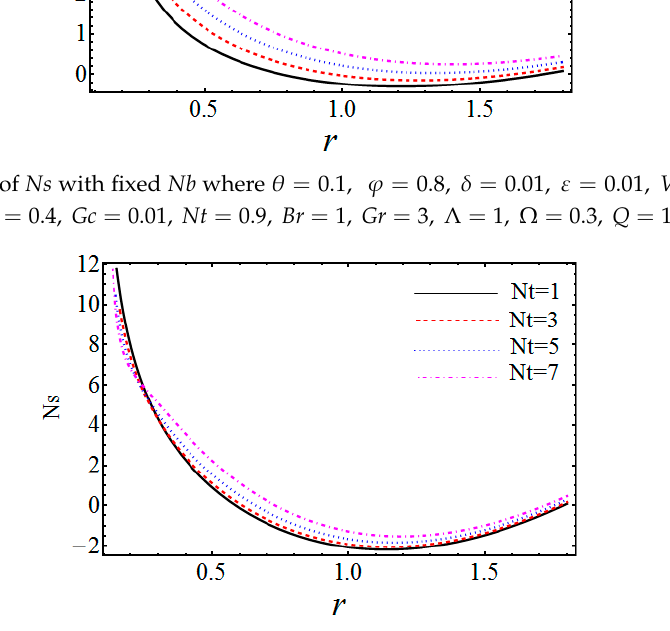
Figure 15. Curves of Ns with fixed Nt where θ = 0.1, ϕ = 0.8, δ = 0.01, ε = 0.01, V = 0.3, λ 1 = Figure 15. Curves of 𝑁𝑠 with fixed 𝑁𝑡 where 𝜃 = 0.1, 𝜑 = 0.8,𝛿 = 0.01, 𝜀 = 0.01, 𝑉 = 0.3, 𝜆 (cid:2869) = 1, z = 0, t = 0.1, Γ = 0.4, Gc = 0.05, Nb = 0.9, Br = 1, Gr = 3, Λ = 1, Ω = 0.3, Q = 1. . Coatings 2020 , 10 , 213 1, 𝑧 = 0,𝑡 = 0.1,Γ = 0.4, 𝐺𝑐 = 0.05, 𝑁𝑏 = 0.9, 𝐵𝑟 = 1, 𝐺𝑟 = 3, Λ = 1, Ω = 0.3, 𝑄 = 1. Figure 15. Curves of 𝑁𝑠 with fixed 𝑁𝑡 where 𝜃 = 0.1, 𝜑 = 0.8,𝛿 = 0.01, 𝜀 = 0.01, 𝑉 = 0.3, 𝜆 (cid:2869) = 1, 𝑧 = 0,𝑡 = 0.1,Γ = 0.4, 𝐺𝑐 = 0.05, 𝑁𝑏 = 0.9, 𝐵𝑟 = 1, 𝐺𝑟 = 3, Λ = 1, Ω = 0.3, 𝑄 = 1.